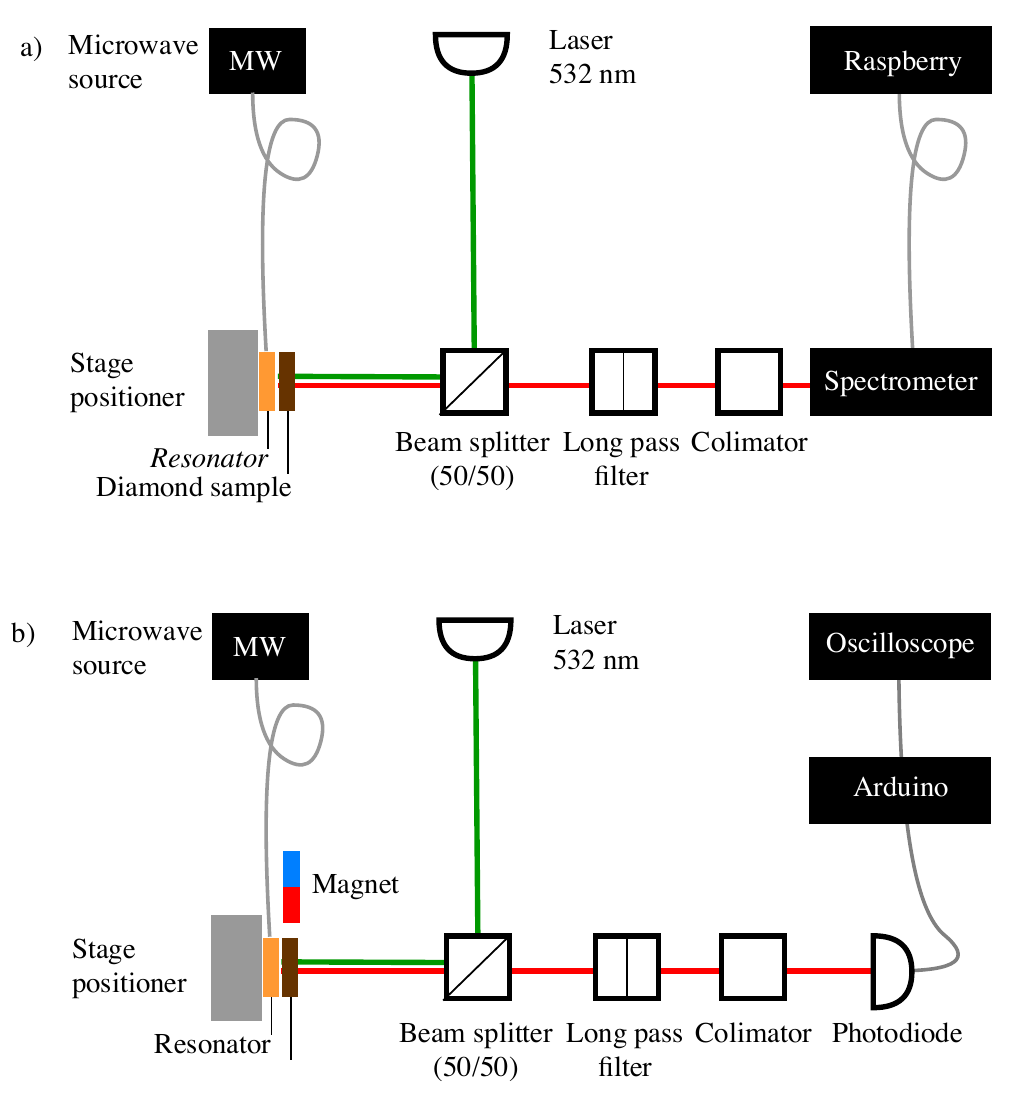
Figure 6. ( a ) Experimental measurement setup used to study the effect of the microwaves on the observed PL. The setup is simplified, the confocal microscope and other elements are replaced by the spectrometer and a Raspberry computer running a Python code to process and visualize the results. The microwave source and the resonator remain the same. ( b ) Experimental and simplified setup adding an electromagnet and using a photodiode (AMS TSL257-LF Amplified Si PD) and a Portenta H7 Arduino board instead of the spectrometer and the Raspberry. The microwave source, the resonator, laser, and optical elements remain the